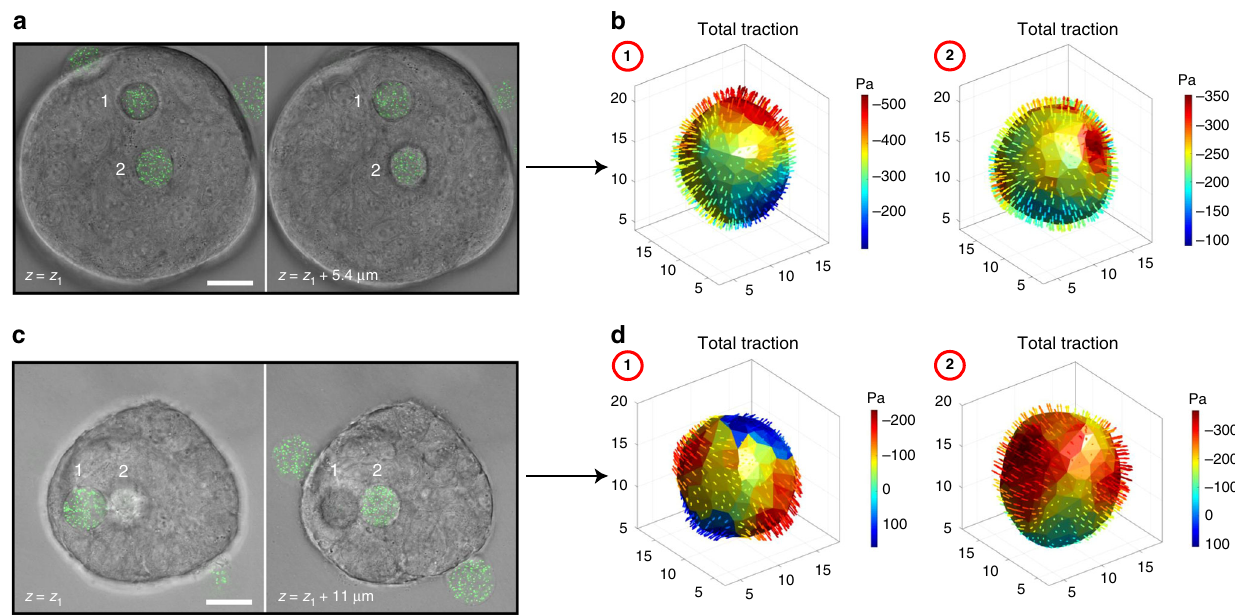
Fig. 8 Spatial distribution of tractions on two microgels inside a melanoma cell colony. a Confocal sections of two embedded microgels (Young ’ s moduli of 1440 Pa) in different focal planes inside a round colony. b Corresponding 3D total traction maps of the two microgels. Note that peak tractions and traction distributions are different for these two microgels in this round colony. c Images of two embedded microgels (Young ’ s moduli of 1440 Pa) at two different z positions in another round colony. d Corresponding 3D total traction maps of the two microgels. Note that tensile tractions are apparent on parts of the microgel #1 and traction distributions are dramatically different for these two microgels in this round colony. All scale bars, 20 µ